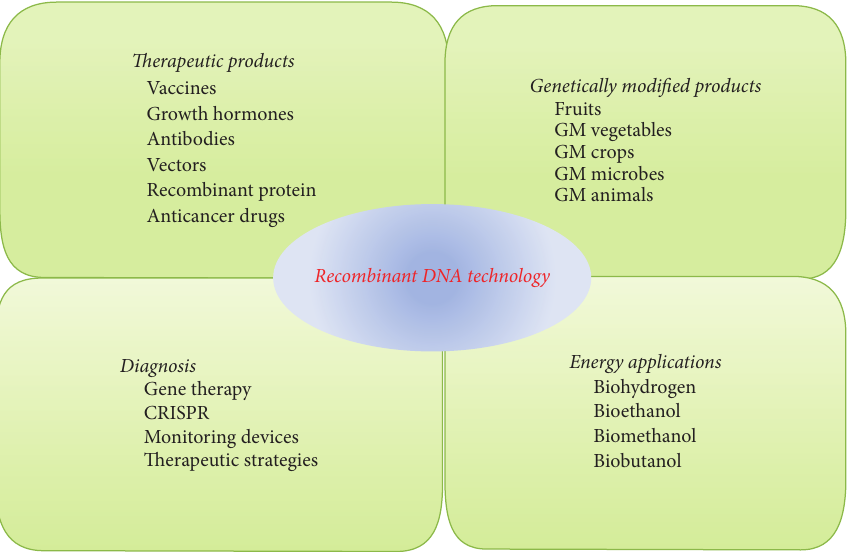
Figure 1: Illustration of various applications of recombinant DNA